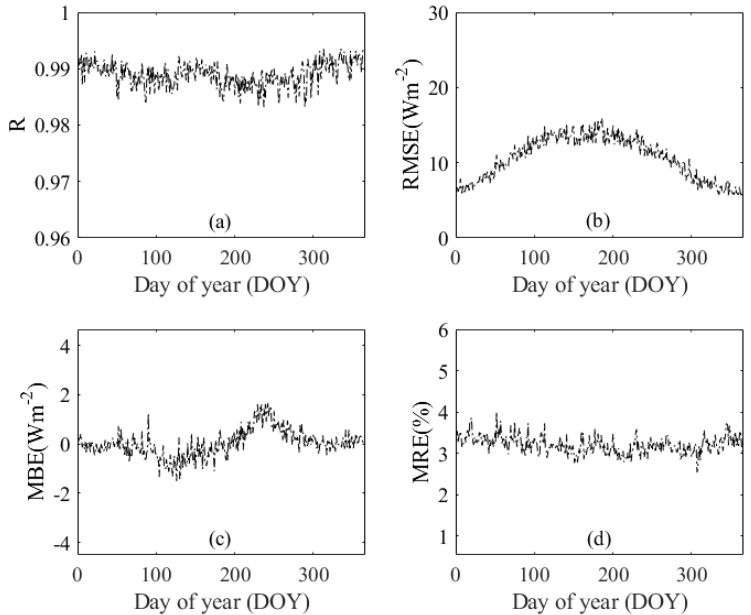
Figure 5. Daily performance of the ERT-based model ( a ) R, ( b ) RMSE, ( c ) MBE, and ( d ) MRE during 2000–2015.